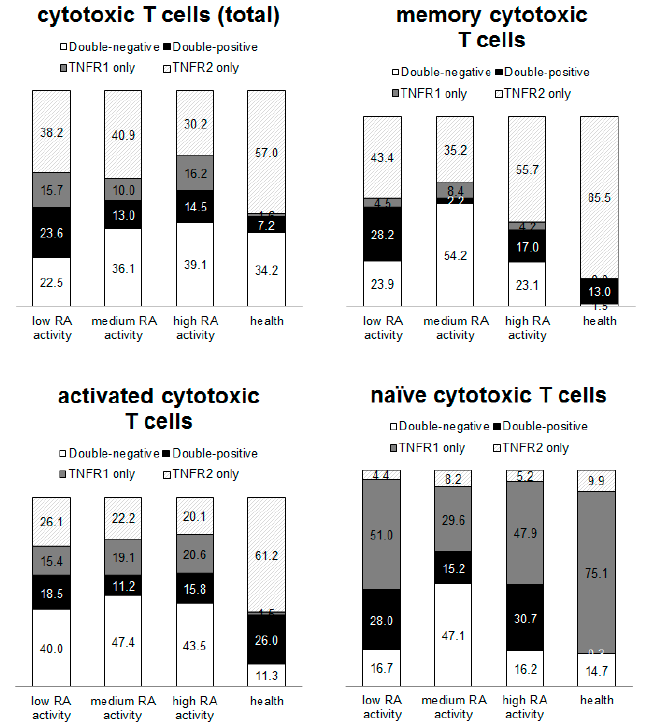
Figure 3. Subpopulations of cytotoxic T cells. Proportion of cells expressing type 1 and 2 receptors for TNF α among cytotoxic T cells. Data have been normalized to the total median value.